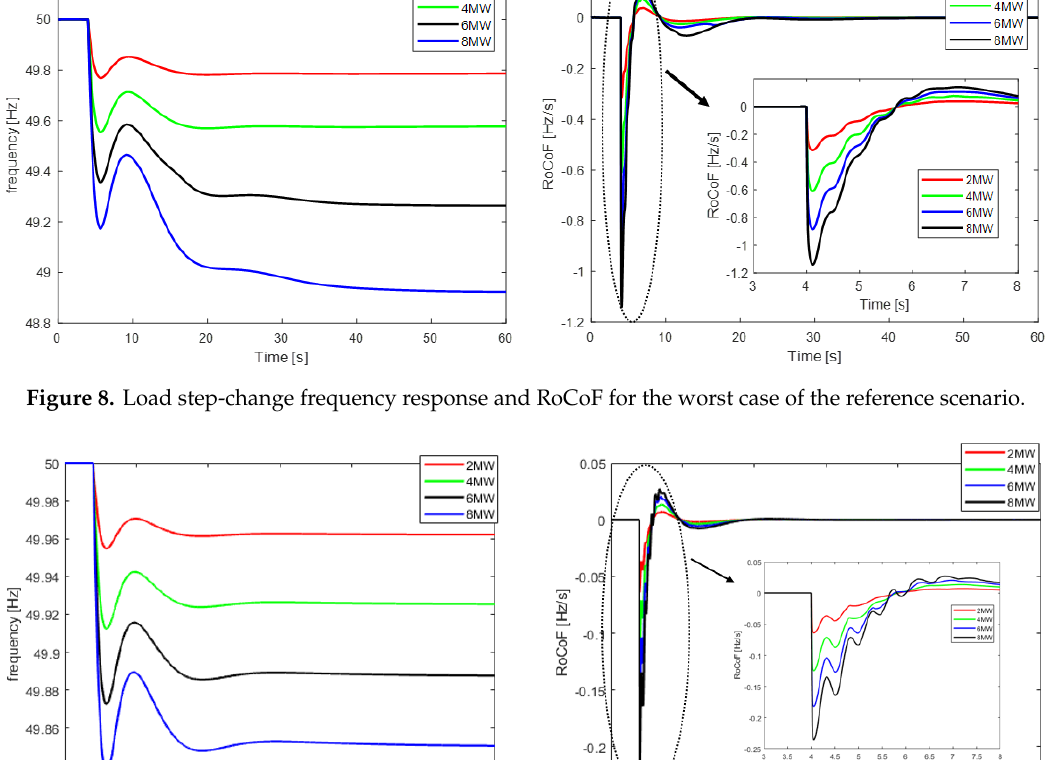
Figure 8. Load step-change frequency response and RoCoF for the worst case of the reference scenario.